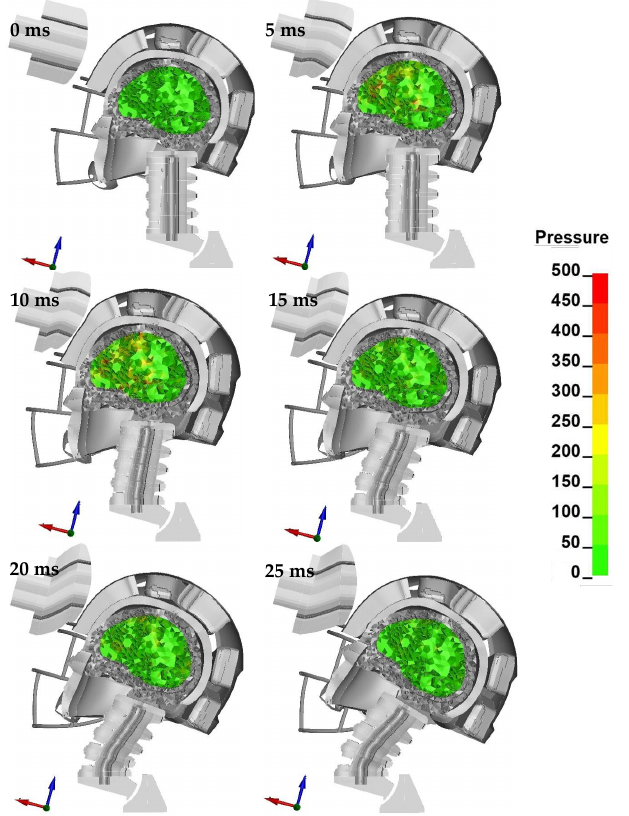
Figure A15. Head kinematics during the numerical test, configuration F, with the cross-section in the median plane and showing the hydrostatic pressure (kPa) in the cerebrum.